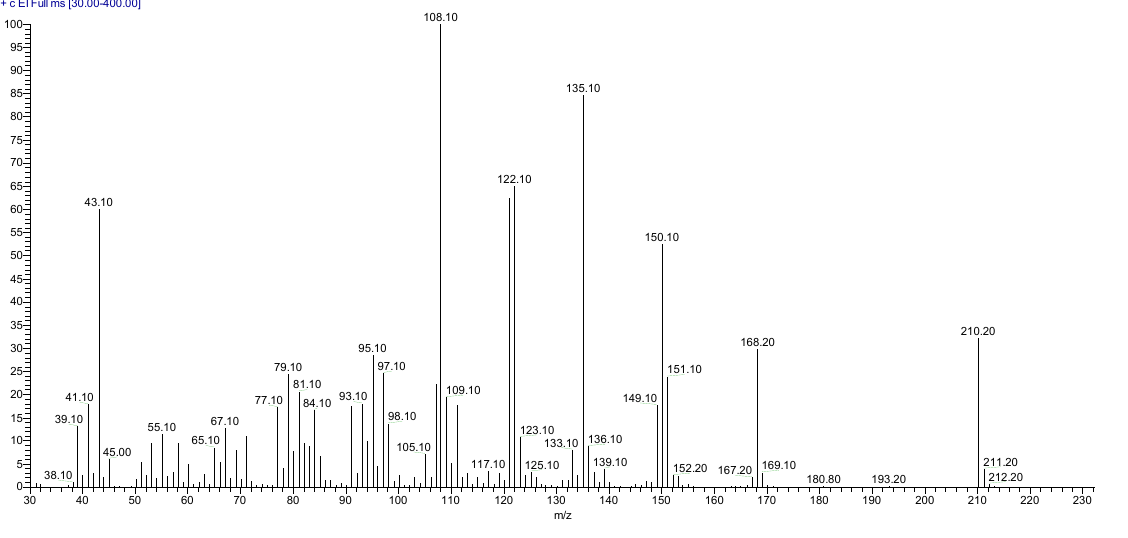
Figure 16. Mass spectrum of a rare compound, 1-acetoxymyodesert-3-ene, using electron impact ionisation.